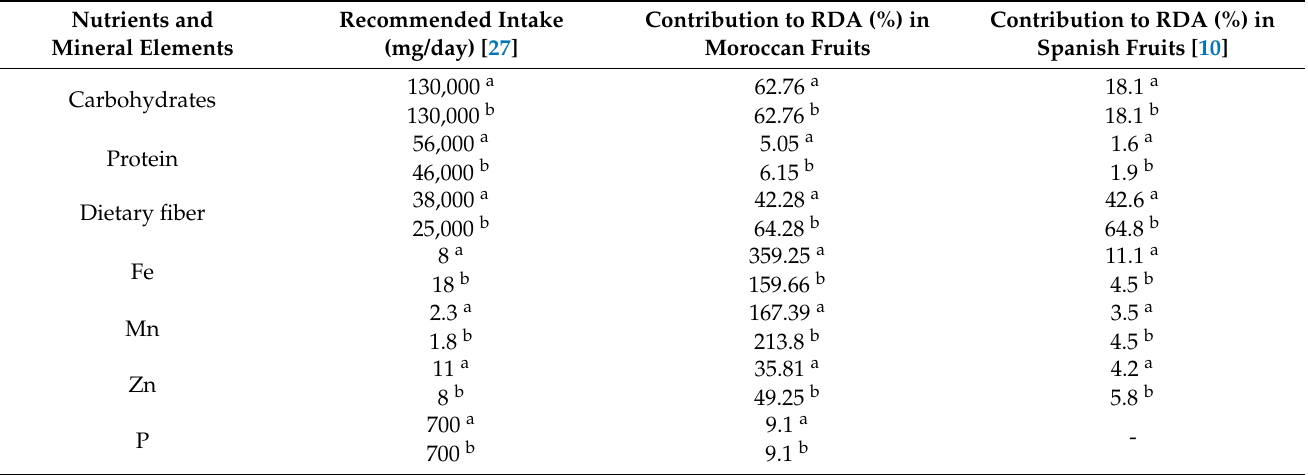
Table 6. Contribution to Recommended Dietary Allowances (RDA) referred by Trumbo et al. [27], to the Moroccan A. unedo fruits (in dry weight), compared to the Spanish strawberry tree (in fresh